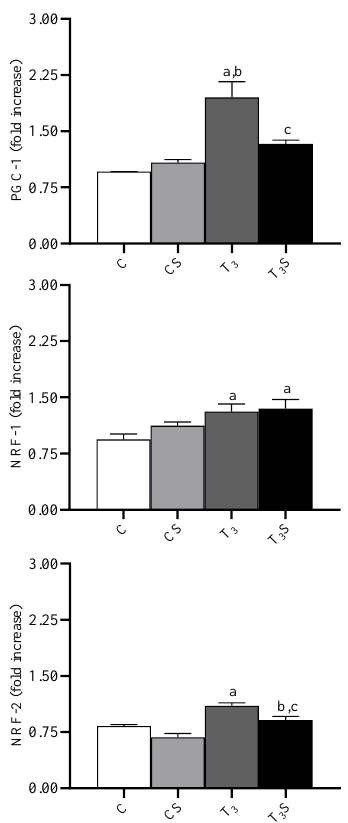
Figure 4. Levels of peroxisomal proliferator-activated receptor- γ coactivator (PGC-1), nuclear respiratory factor 1 (NRF-1), and nuclear respiratory factor 2 (NRF-2) protein expressions in rat livers. Liver total proteins from hypothyroid from C, control rats; CS, control rats fed with Chlorella sorokiniana ; T 3 , rats made hyperthyroid by ip. T 3 administration; and T 3 S, hyperthyroid rats fed with Chlorella sorokiniana were isolated and analyzed using Western blot analyses. A representative blot of PGC-1, NRF-1, NRF-2, and actin protein expressions is shown (above). The values reported in the graphs are the means ± S.E.M. of three independent experiments performed on three di ff erent livers. Ratios of band intensities to the β -actin band intensities were compared with a standard control sample that was assigned a value of 1. a significant vs. C, b significant vs. CS, and c significant vs. T 3 . The level of significance was chosen as p < 0.05.